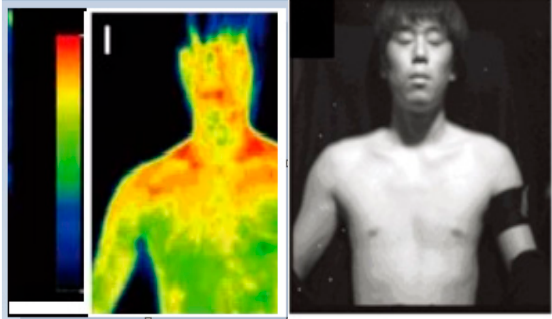
Figure 6. Illuminated vs. infrared images of the subject.